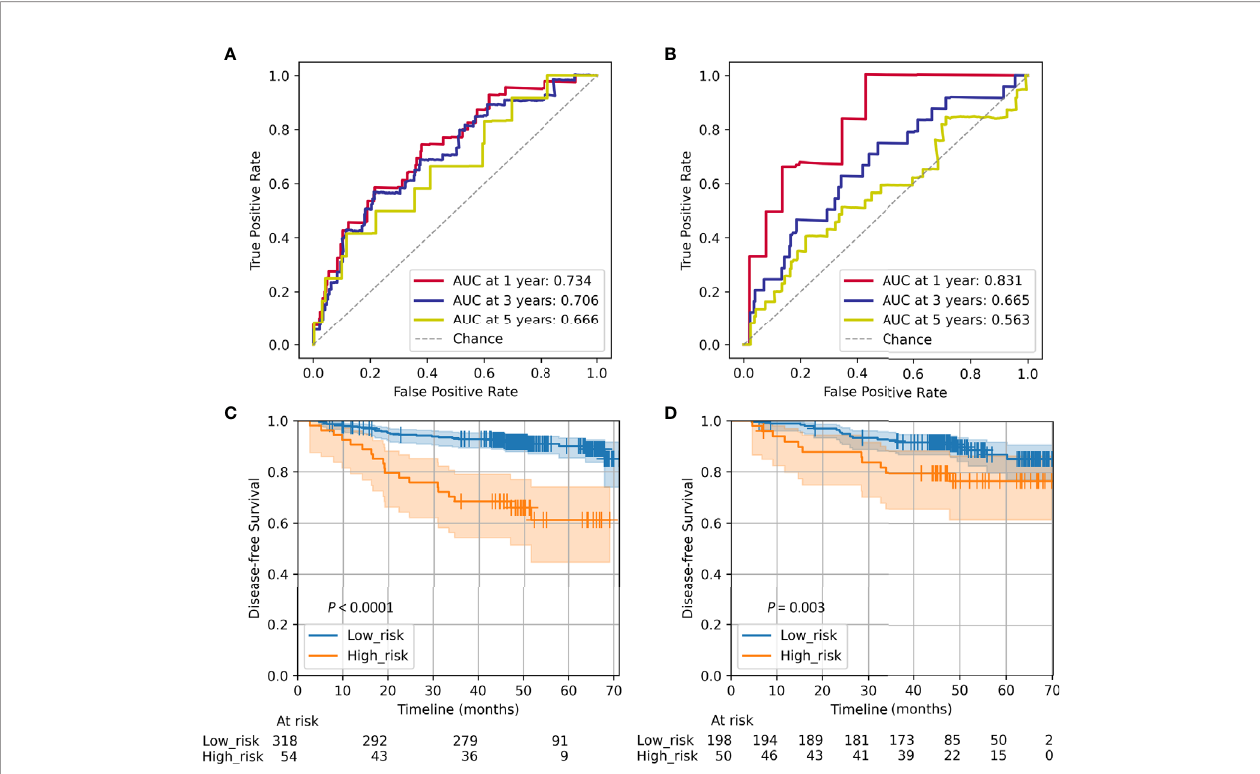
FIGURE 1 | Radiomics score measured by time-dependent ROC curves and Kaplan – Meier survival curves in the training and validation cohorts. We used AUCs at 1, 3, and 5 years to assess prognostic accuracy in the training (A) and validation (B) cohorts. A signi fi cant association of the Rad-score with DFS was shown in the training (C) and validation (D) cohorts. We calculated P values using the log-rank test. Data are the AUC or P -value. ROC, receiver operator characteristics; AUC, area under the curve; DFS, disease-free survival.